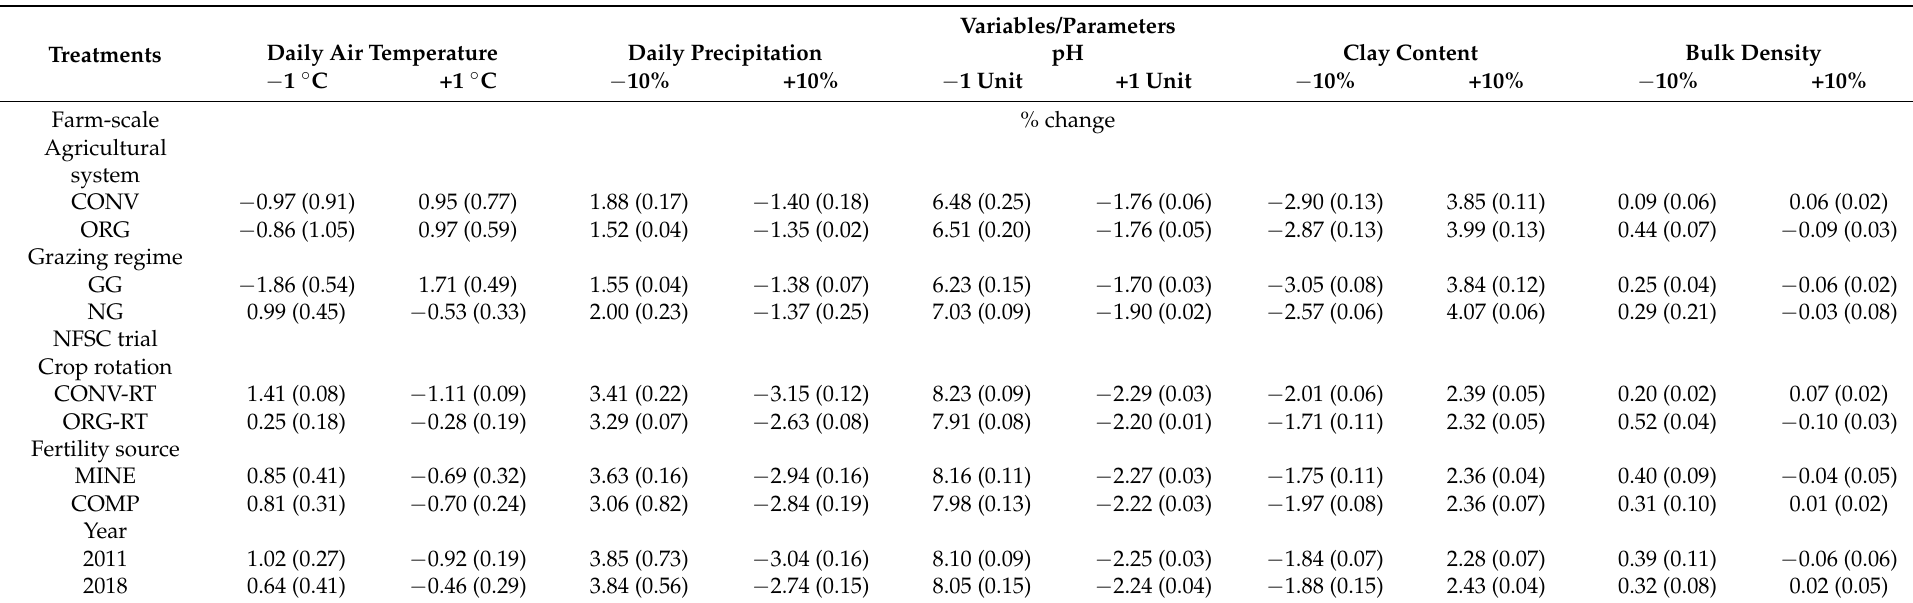
Table 4. Model sensitivity in the simulation of soil C stocks for the farm-scale study, encompassing agricultural system (conventional—CONV and organic—ORG) and grazing regime (non-grazed—NG and grazed—GG), and for the Nafferton Factorial Systems Comparison (NFSC) trial treatments, including crop rotation (conventional—CONV-RT and organic—ORG-RT), fertility source (mineral—MINE and compost—COMP) and year of sampling (2011 and 2018), to different input